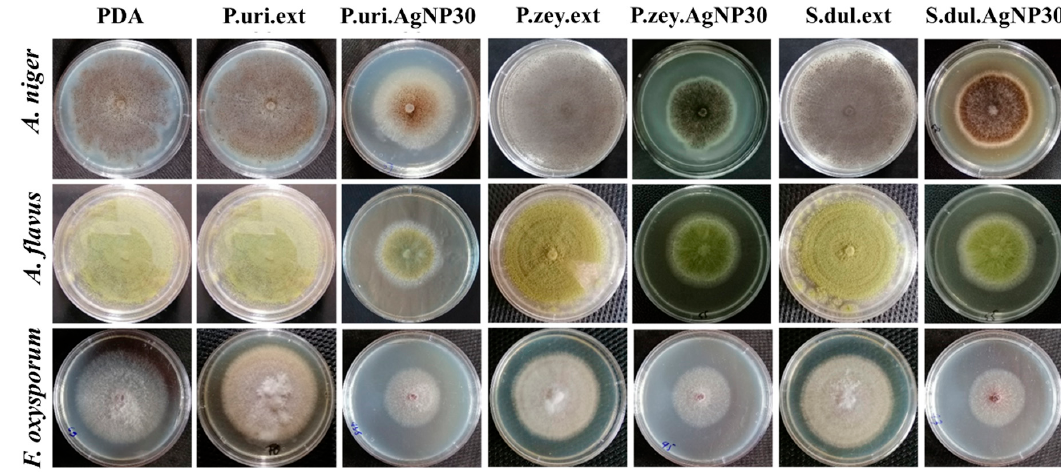
Figure 4. Three fungal strains including A. niger, A. flavus, and F. oxysporum were culture in different agar matrix after 96 hours.